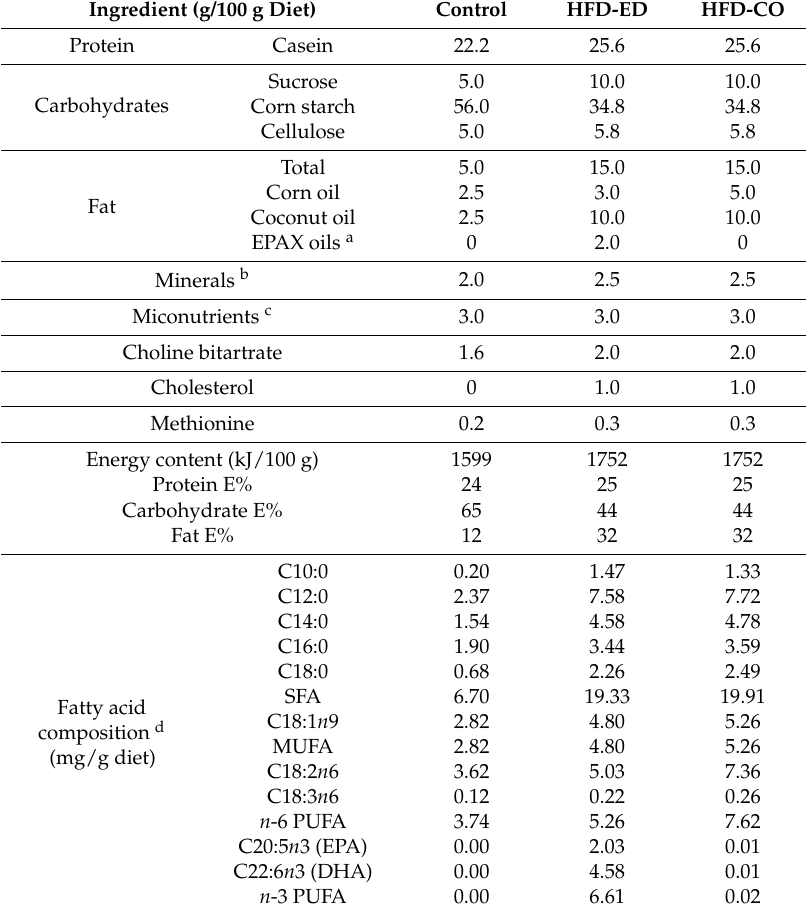
Table 2. Diet Compositions Namely Control, HFD-ED and HFD-Corn Oil (CO)